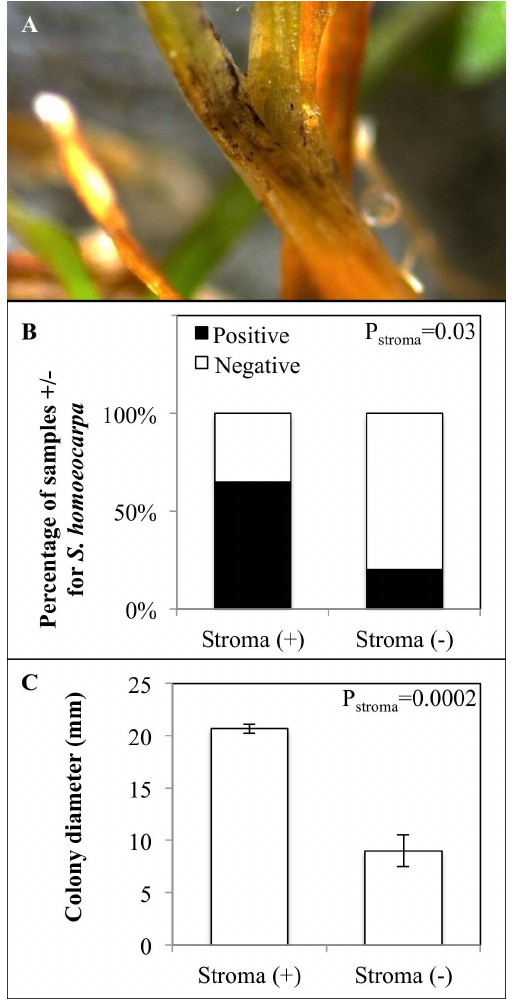
Figure 2. Stroma on creeping bentgrass leaf blades and its effect on isolation on S. homoeocarpa . A , typical stroma-like material observed on a turfgrass leaf blade was brown in color and appeared as flaky, plate-like material. B , The percentage of CRB leaf blades with and without visible stroma from which S. homoeocarpa was isolated. P-value from ANOVA using the binary distribution for presence/absence of S. homoeocarpa and a =0.05. C , Average diameter of S. homoeocarpa colonies 48 h after plating leaf blades with or without visible stroma. P-value is from ANOVA with the normal distribution and a =0.05. Error bars represent 6 one standard error of the mean (n=5).